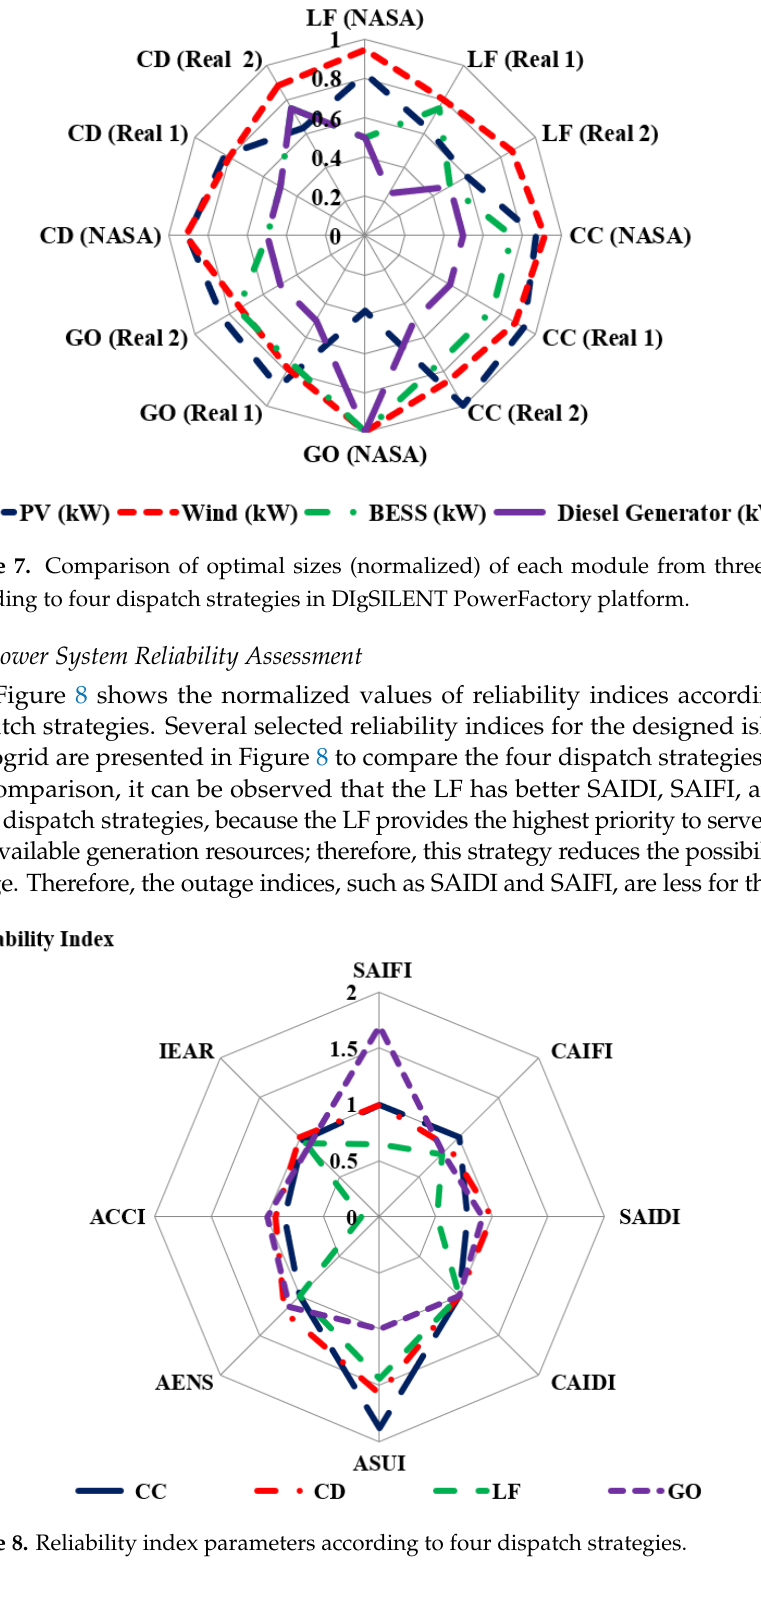
Figure 6. Comparison of NPC, COE, and CO 2 emission (normalized) according to four dispatch strategies for three datasets.